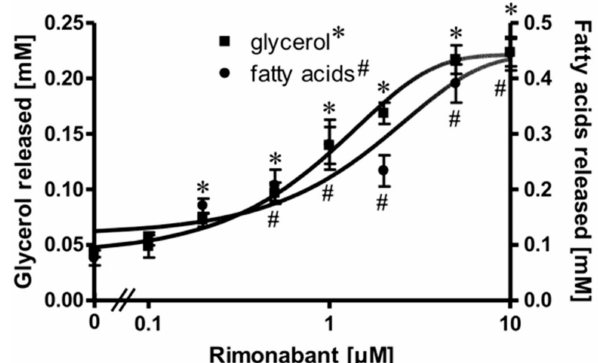
Figure 1. Stimulation of adipocyte lipolysis by Rimonabant. Primary rat adipocytes were incubated (3 h, 37 ◦ C) in the absence or presence of increasing concentrations of Rimonabant. The concentrations of glycerol ( (cid:4) ) and (fatty acids) FA ( • ) released into the incubation medium were assayed enzymatically. Mean ± SD of three di ff erent cell preparations with incubations in triplicate and measurements in duplicate. *, # p ≤ 0.01 vs. absence of